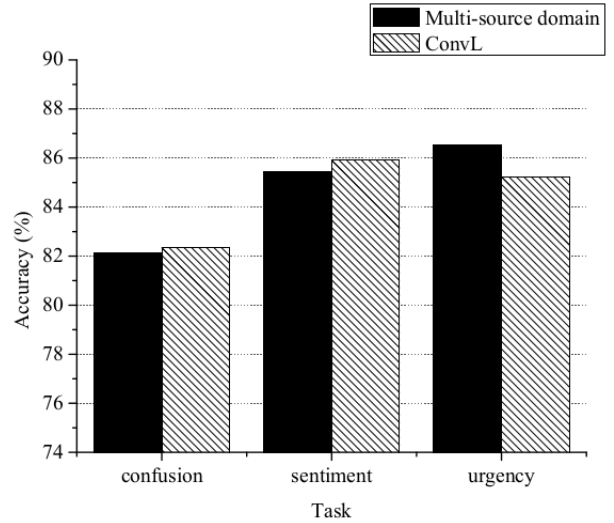
Figure 5. Comparison of a multi-source domain course and